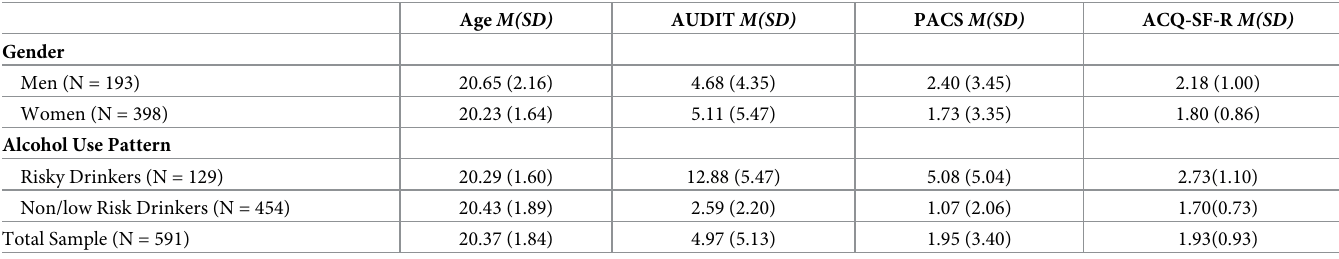
Table 1. Age and alcohol consumption by gender and alcohol use